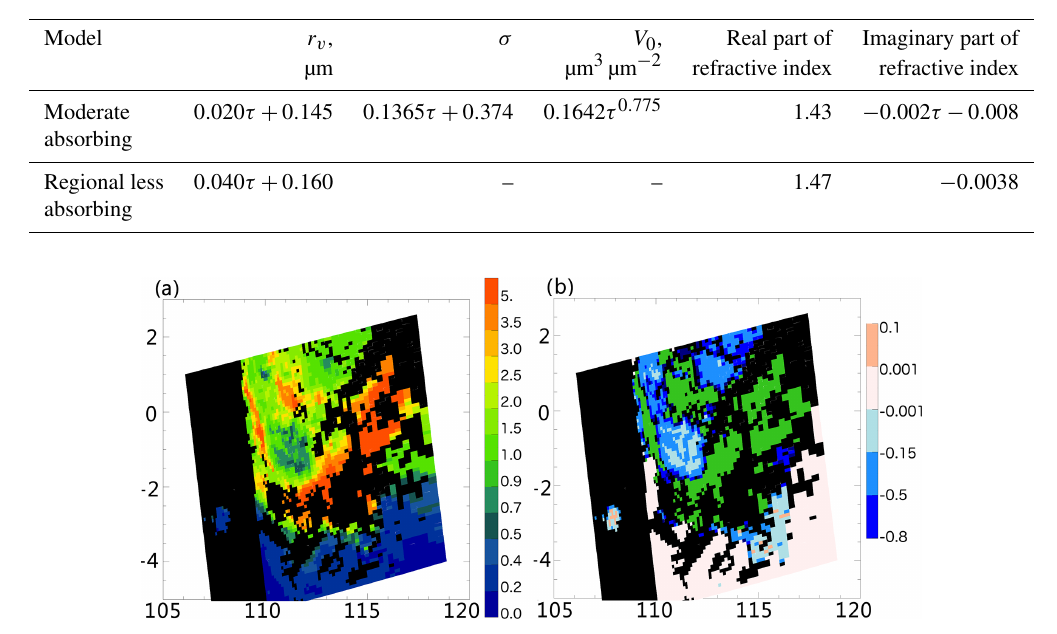
Figure 5. (a) Research AOD at 0.55µm retrieved from the case study of 22 September 2015 using altered thresholds on the NDVI test, cloud mask, upper bound limits of the retrieval and a new regional aerosol model. (b) The differences between the research AOD (panel a ) and the DT AOD (Fig. 2b). The increased research AOD data coverage is shown in